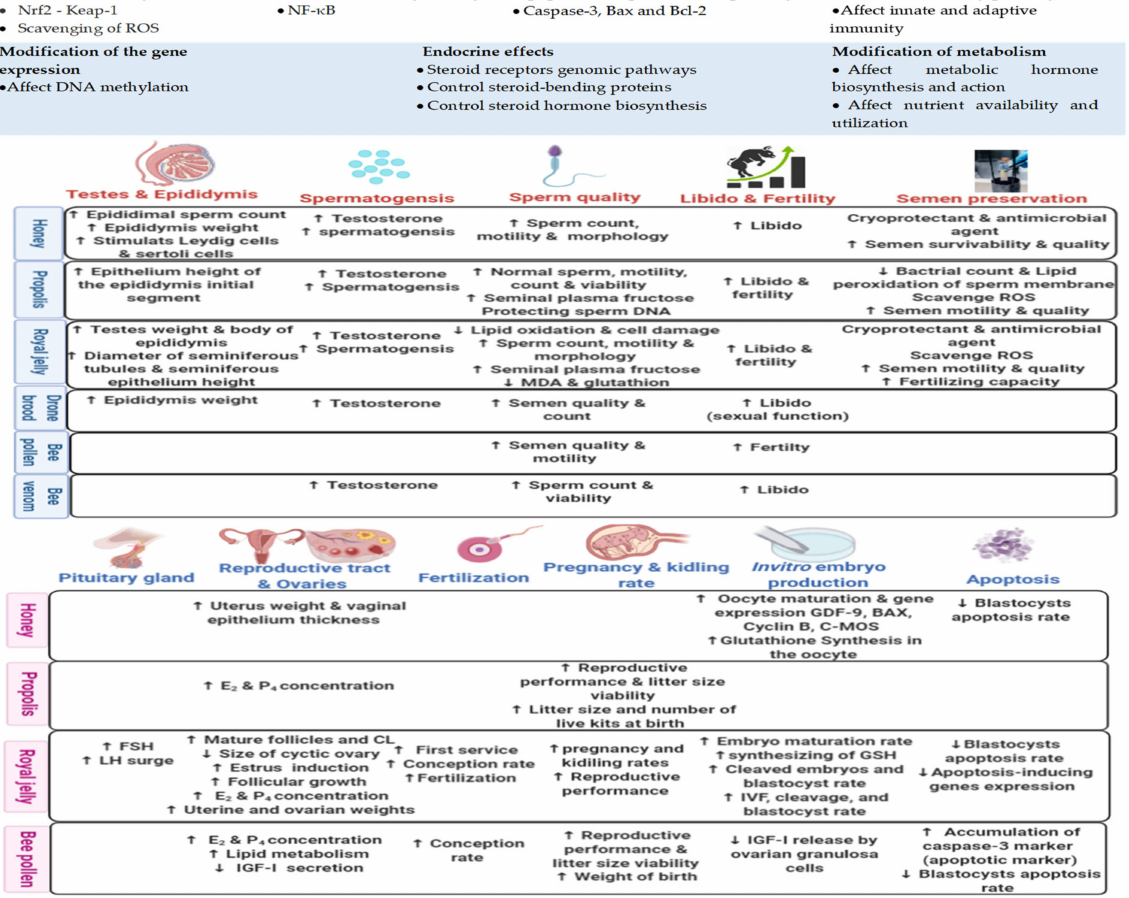
Figure 1. Potential effects of honeybee products on reproductive functions and assisted reproductive techniques (ARTs) in mammals. BAX: bcl-2-like protein 4, Bcl-2: B-cell lymphoma 2, C-MOS: complementary metal–oxide–semiconductor, E 2 : estradiol-17 β , FSH: follicle stimulating hormone, GDF-9: growth differentiation factor 9, IGF-I: insulin-like growth factor I, LH: luteinizing hormone, Nrf2-Keap-1: nuclear factor erythroid 2-related factor 2-Keap-1, NF- κ B: nuclear factor kappa-light-chain-enhancer of activated B cells, P 4 : progesterone, ROS: reactive oxygen